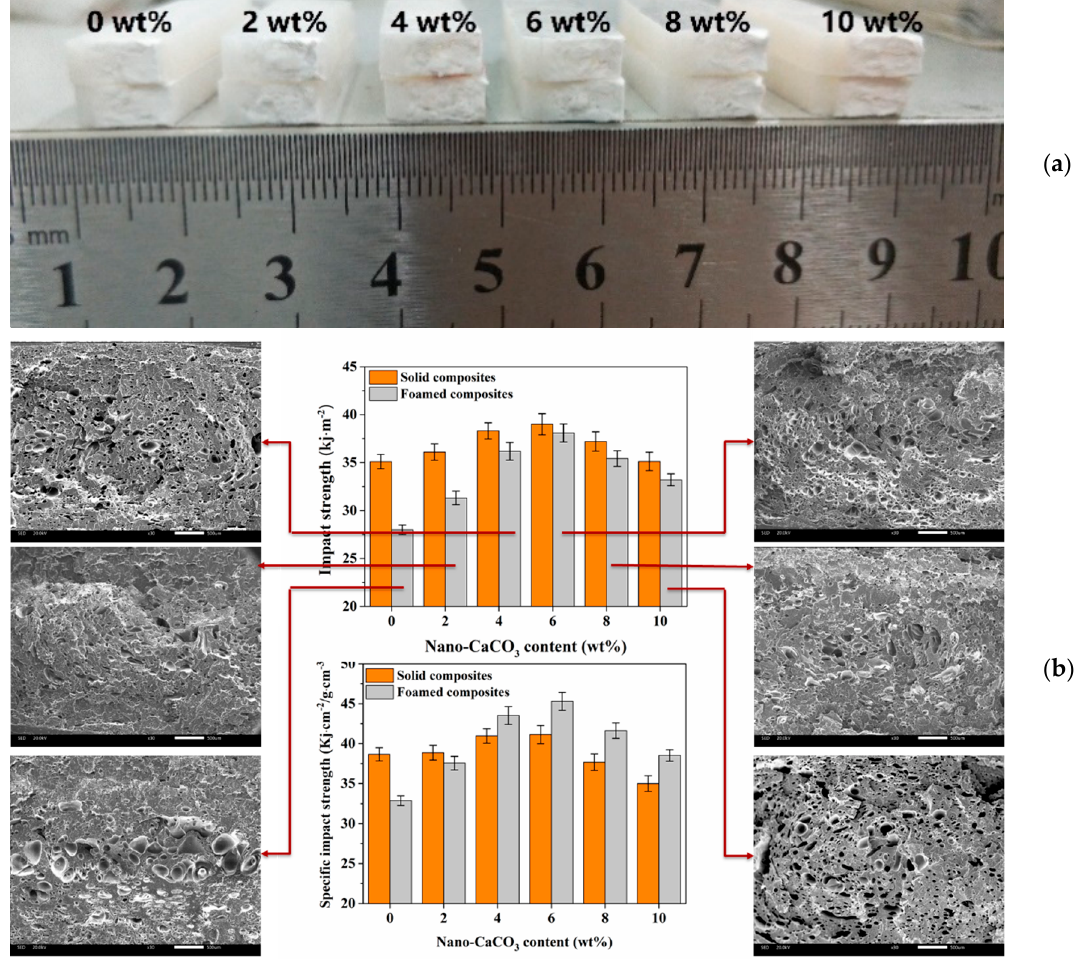
Figure 8. Impact results of solid and foamed composites: ( a ) samples after impact tests; ( b ) the impact strength and specific impact strength.